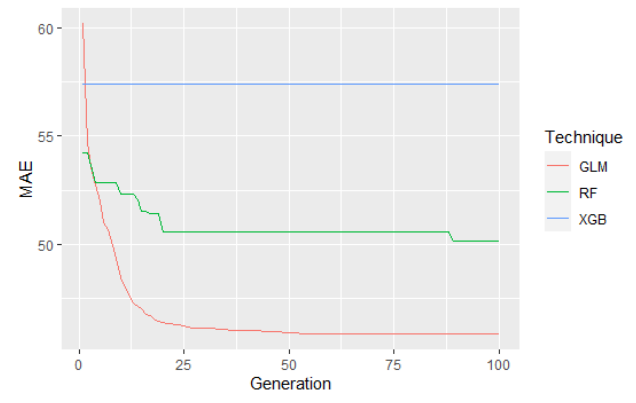
Figure 3. Evolution of MAEs over generations with the GA .